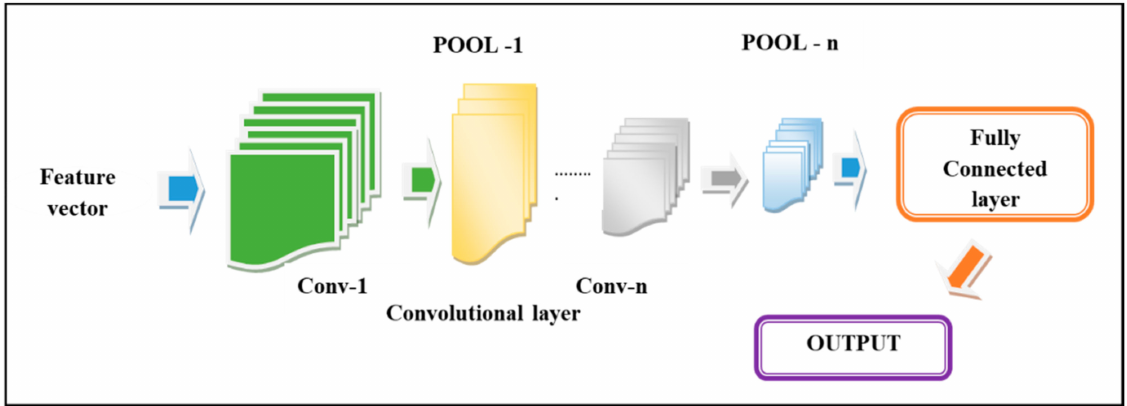
Figure 2. Structure of Deep Convolutional Neural Network (DCNN) for the construction of prediction